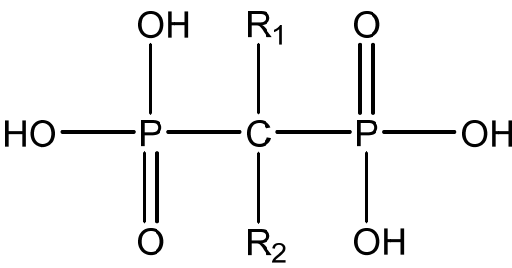
Figure 4. The general molecular structure of bisphosphonates.